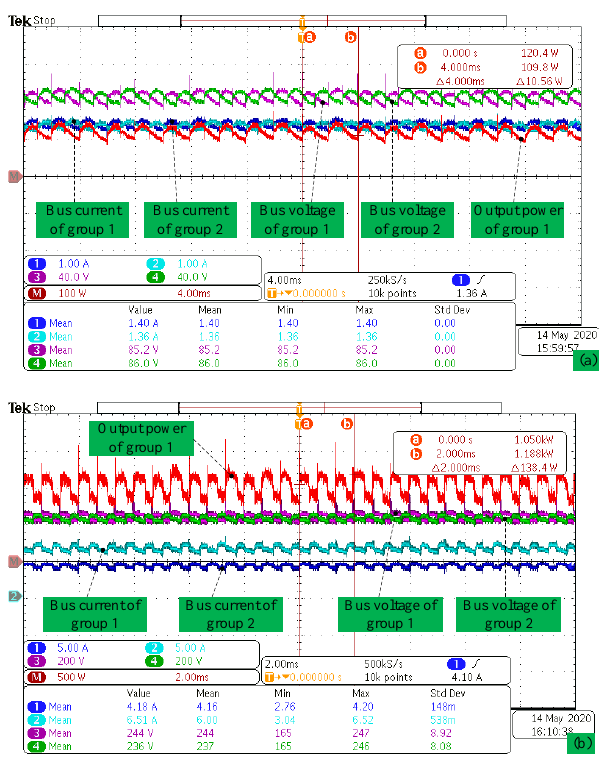
Figure 27. Bus current, bus voltage, and output power wave. ( a ) Speed n = 1000 rpm, ( b ) speed n = 3000 rpm.